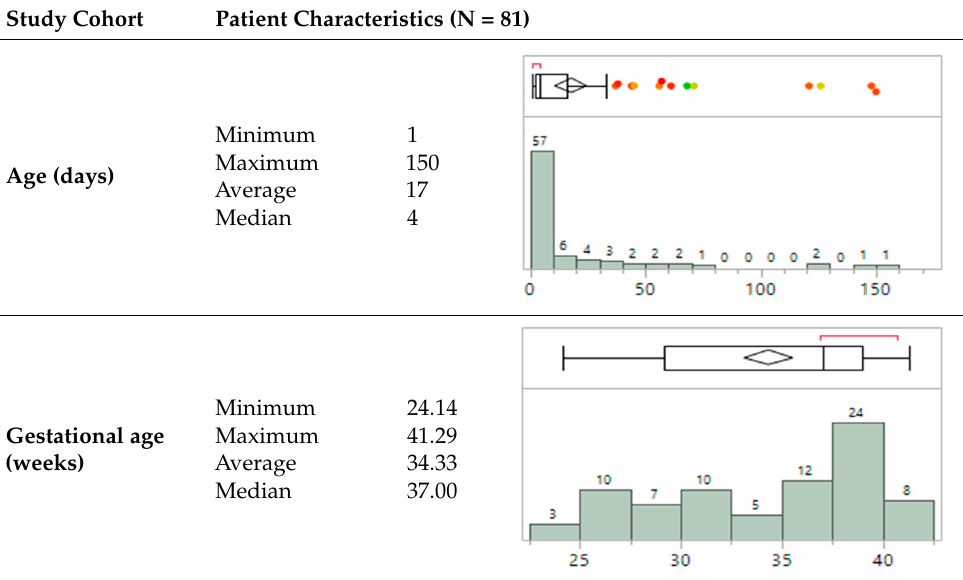
Table 3. Characteristics of the study cohort. Normotensive, not on any inotropic support during the measurement